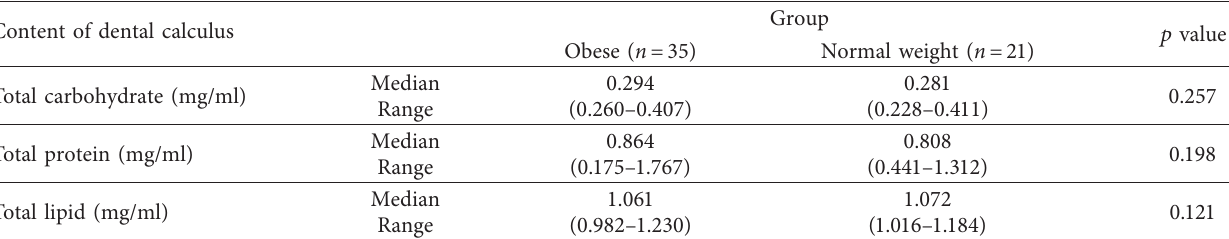
Table 5: Comparison of the macronutrient content of dental calculus between obese and normal-weight